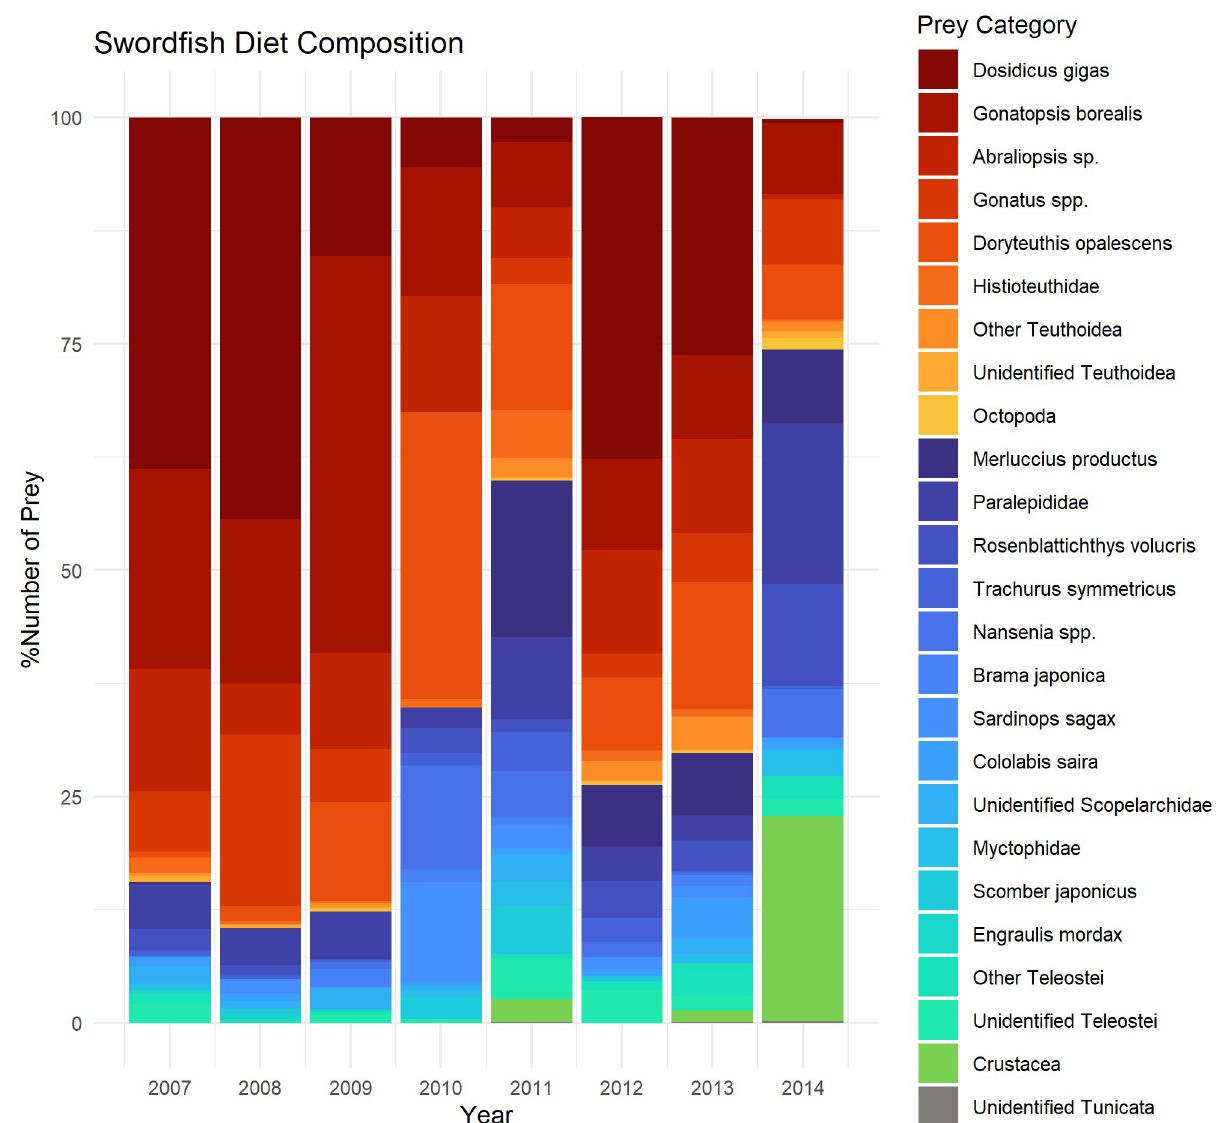
Fig 4. Composition (%N) by year for swordfish diet components. Red = Teuthoidea; Blue = Teleostei; Green = Crustacea; Grey = Tunicata.